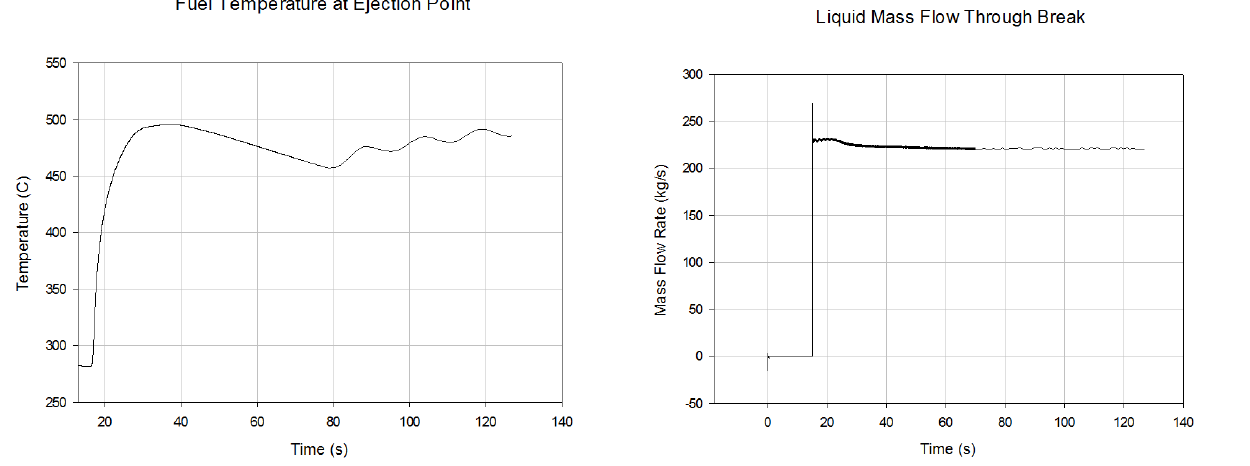
Figure 22. Mass flow through the break.